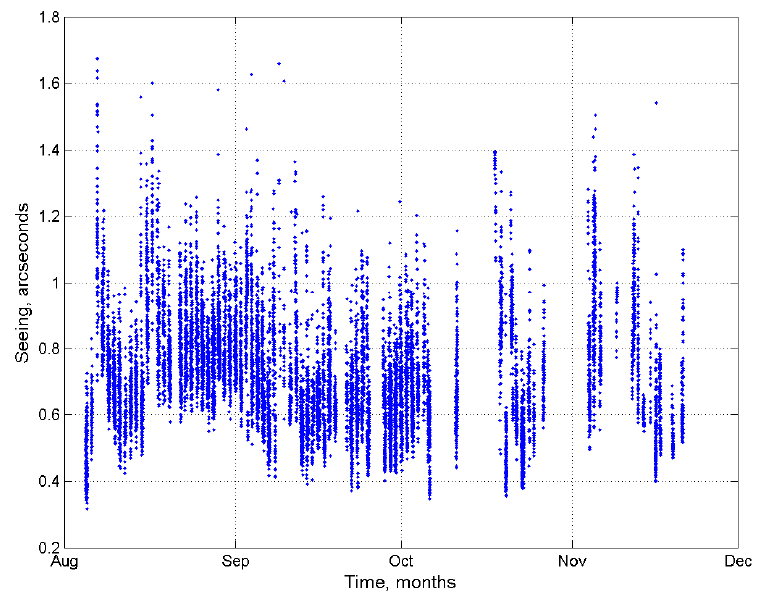
Figure 2. Astronomical seeing measured in August–November, 2018. The cumulative distribution of astronomical seeing is shown in Figure 3. The blue color shows the cumulative distribution of astronomical seeing obtained in 2018. The dashed line shows the cumulative distribution of astronomical seeing obtained in 1996– 2003. As can be seen from this graph, the median value of astronomical seeing for 2018 is 0.70 arcseconds and for 1996–2003 it was 0.71 arcseconds [12].